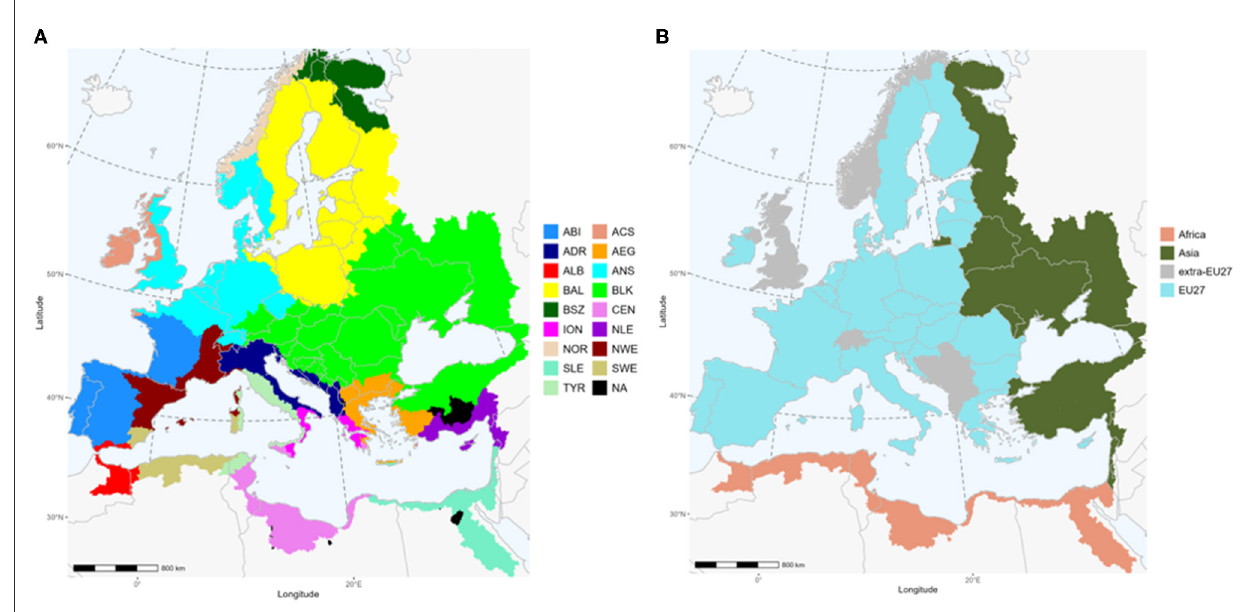
FIGURE1 Study area showing the 17 marine regions (A) (excluding the areas that do not drain into the seas) and the continents (B)